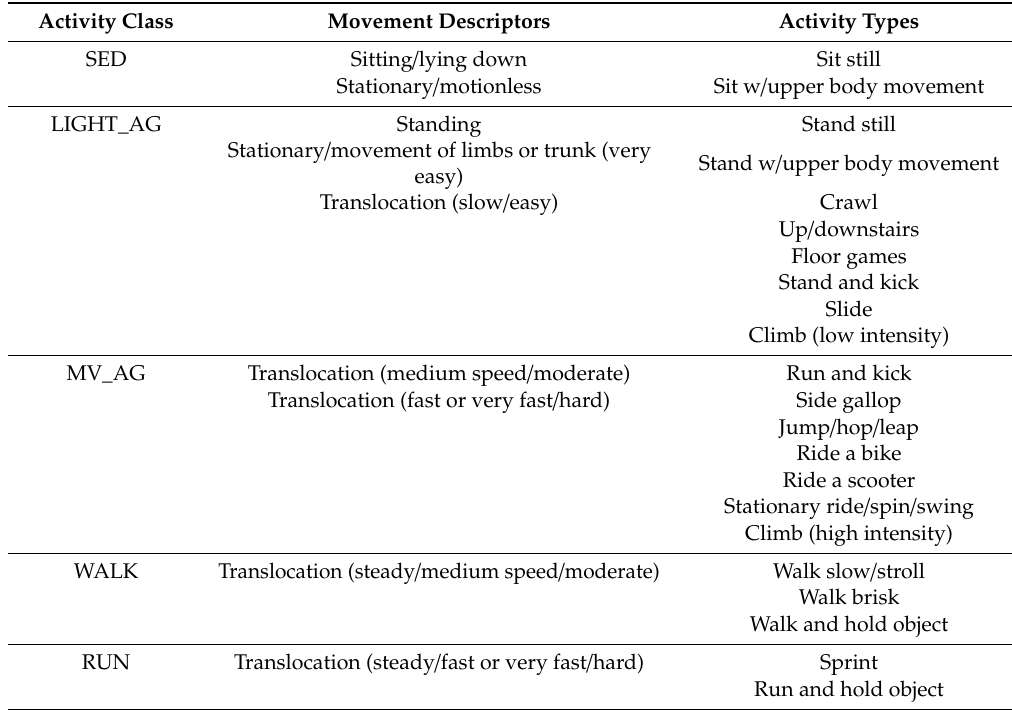
Table 1. Description of the five activity